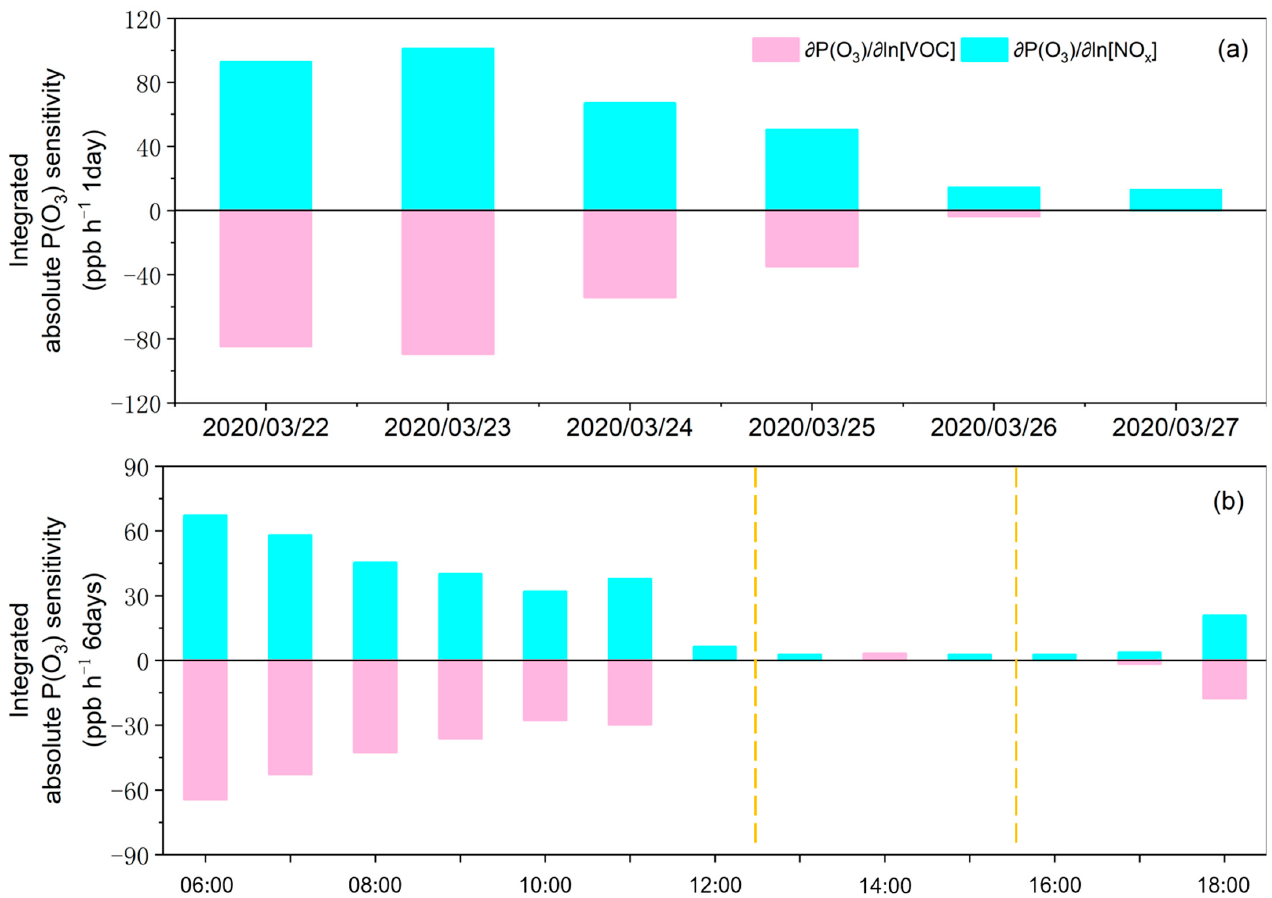
( O 3 ) and ∂ P and (cid:2986)(cid:2900)((cid:2899) (cid:3119) ) ∂ In ( VOC ) ∂ In ( NOx ) (cid:2986)(cid:2893)(cid:2924)((cid:2906)(cid:2899)(cid:2887)) (cid:2986)(cid:2893)(cid:2924)((cid:2898)(cid:2899)(cid:2934))